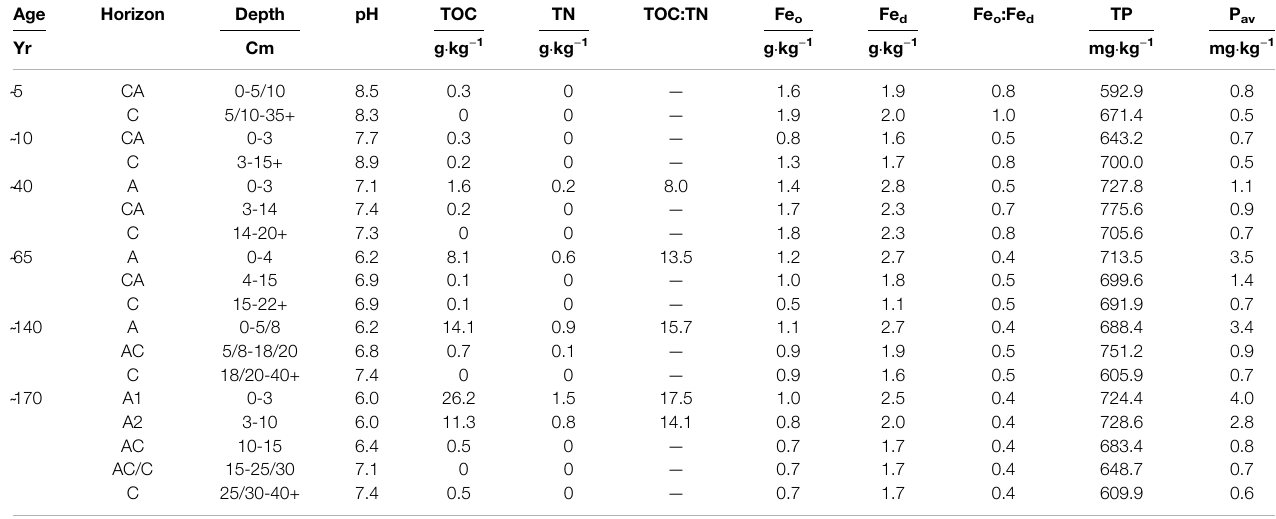
TABLE 2 | Chemical properties of soil pits along the six stages of the chronosequence. pH; TOC, total organic carbon; TN, total nitrogen; Fe d , pedogenic iron oxides; Fe o , iron amorphous oxides; Fe o :Fe d , poorly crystalline to pedogenic iron oxide ratio; TP, total phosphorus; P av , bicarbonate extractable (available) phosphorus.